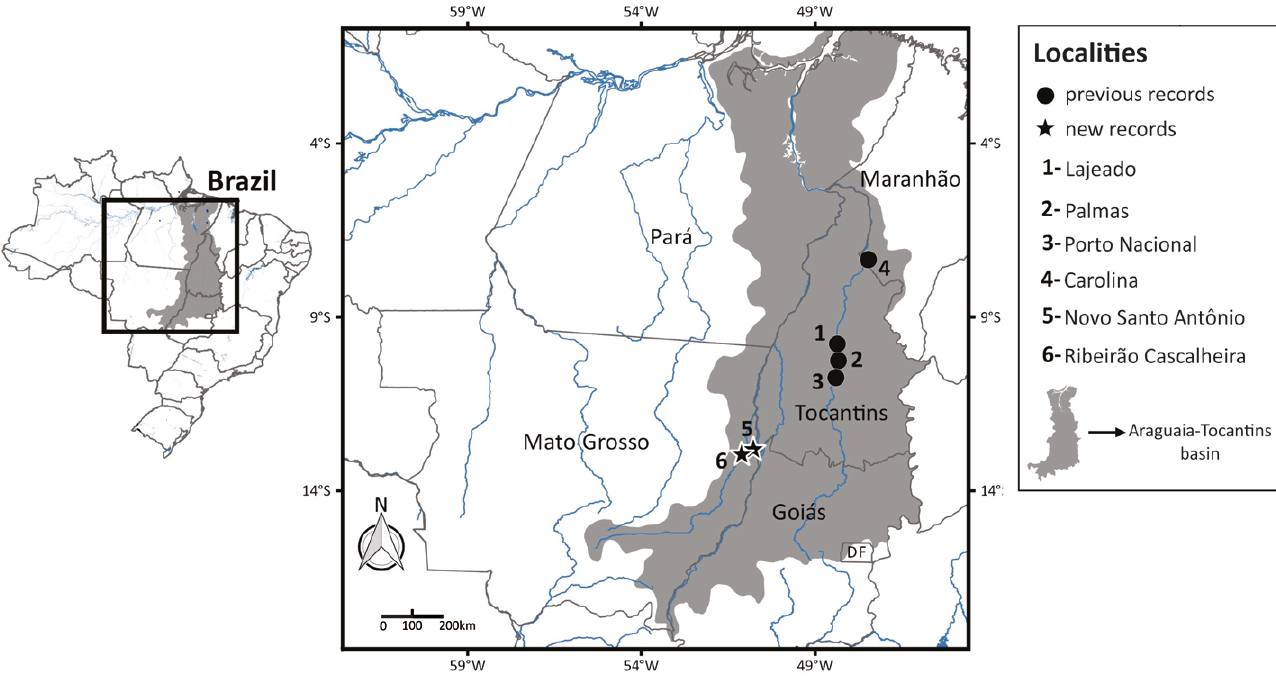
Figure 1. Updated map of the geographical distribution of Hydrodynastes melanogigas . Black stars show new records for the species, and black circles show previously known localities ( F ranco et al. 2007: localities 1–3; S ilva J r et al. 2012: locality